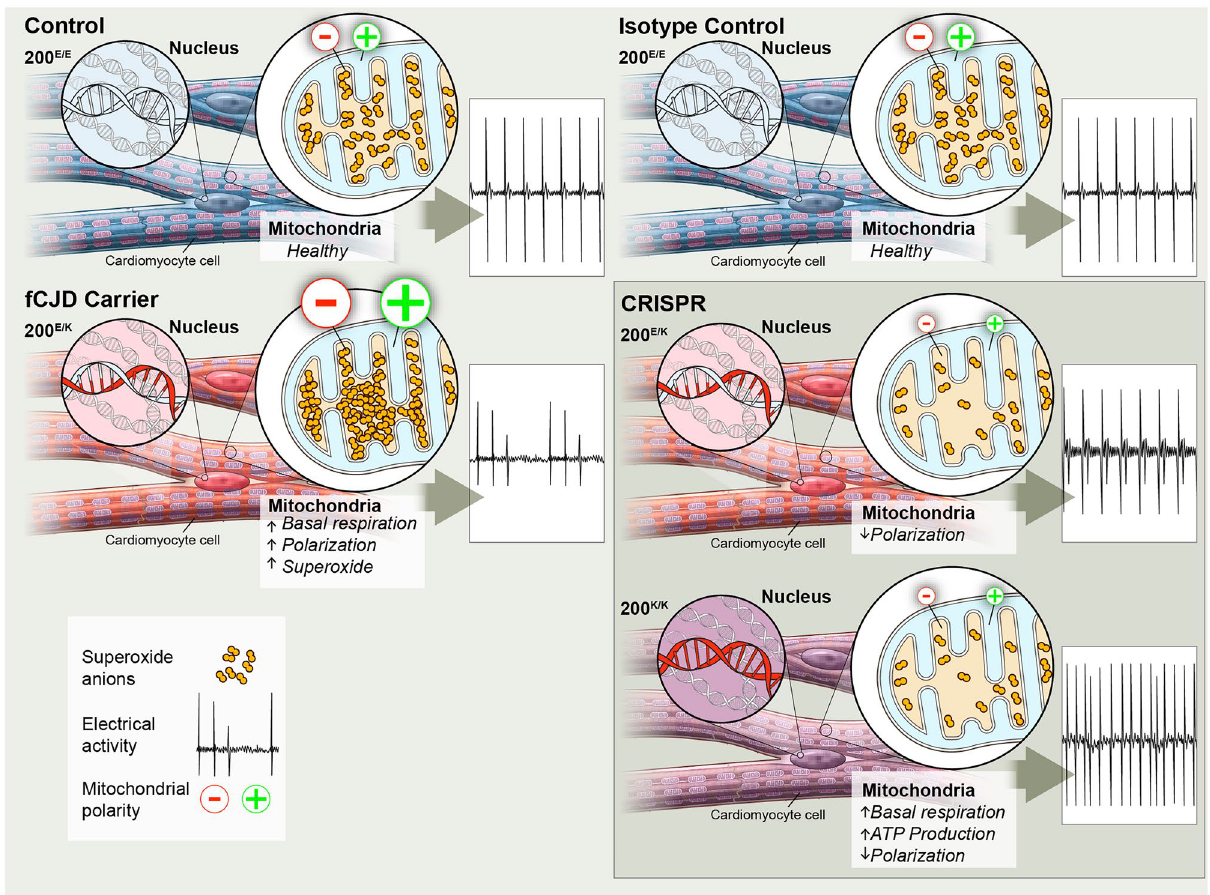
Figure 7. Schematic summary of findings. Diagrammatic representation of the differences between the E200K donor-derived cardiomyocytes and the cardiomyocytes from the control no-known-disease donors (left) and the genetically matched single or double mutation (right). For the isotopically matched lines, only the control mutation inserted lines are shown but the conditions that were consistently changed across both CRISPR-Cas9 engineered lines are indicated. Arrows indicate increased or decreased